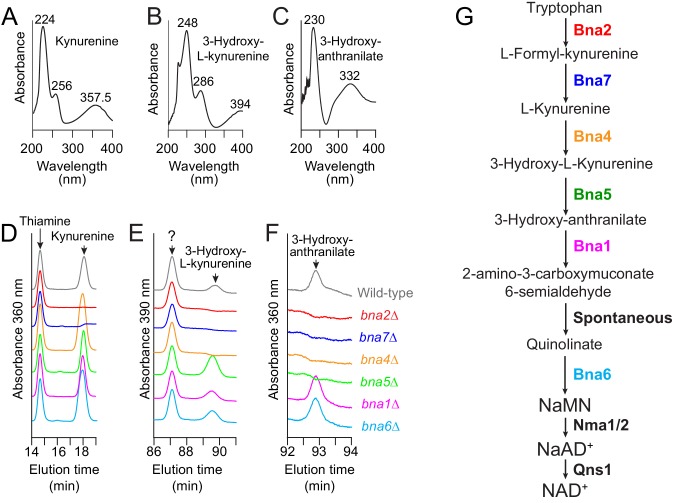
Identification of NAD+ de novo pathway intermediates.(A–C) Absorption spectra observed for some NAD+-de novo pathway intermediates in the ion chromatography conditions used. Values indicate the wavelength of absorption maxima (in nm). (D–F) Identification of the peaks corresponding to kynurenine, 3-hydroxy-L-kynurenine and 3-hydroxy-anthranilate using bna knock-out mutants. Wild-type (BY4742) and bna-mutant (bna2: Y10838; bna7: Y10904; bna4: Y5822; bna5: Y10903; bna1: Y10901 and bna6: Y5891) strains were exponentially grown in SDcasaWAU medium for 24 hr, harvested by filtration and shifted for 7 hr in SDcasaWAU medium lacking nicotinic acid (see Materials and methods section). Metabolite extraction and separation by liquid chromatography were performed as in Figure 2. Panels correspond to the chromatogram sections containing peaks of interest. (G) Simplified representation of the NAD+ de novo pathway showing the block occasioned by each bna mutant. NaMN: nicotinic acid mononucleotide. NaAD+: nicotinic acid adenine dinucleotide. Of note, L-Formyl-kynurenine and quinolinic acid could not be detected in our experimental setup.